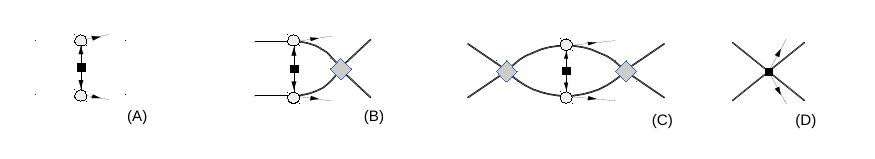
Figure 2. Diagrams for nn → ppe − e − in chiral EFT, with the double lines referring to nucleons, single lines to leptons, and the black square to the insertion of m ββ . The contact term ( D ) is required for the renormalization of diagram ( C